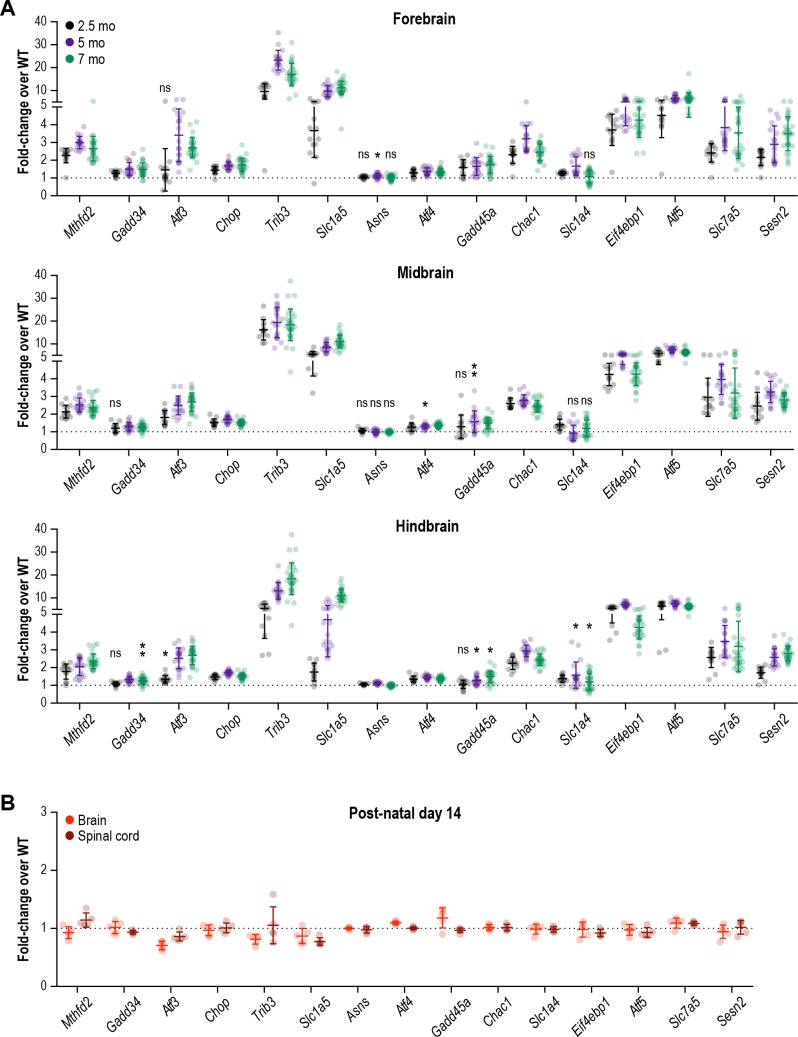
A robust and chronic ISR is triggered in all regions of the R191H mouse brain by 2.5 months.(A) mRNA expression in R191H brain regions at 2.5 (N = 13/genotype), 5 (N = 20 WT, 19 R191H) and 7 (N = 30/genotype) months of age. *p<0.01; **p<10-3; nsp>0.05 by Student’s t-test with Holm-Sidak correction (compared to WT). Transcripts without symbols were highly significant with p<10−4. (B) mRNA expression in R191H whole brain and spinal cord at postnatal day 14. N = 5/genotype. None of the transcripts were significantly different from WT (p>0.1 by Student’s t-test with Holm-Sidak correction). For (A) and (B), males and females were combined as there was no significant difference between sexes. Data are shown normalized to WT transcript levels. Bars, mean ±SD. A table of p-values from tests is available in Figure 3—source data 1.